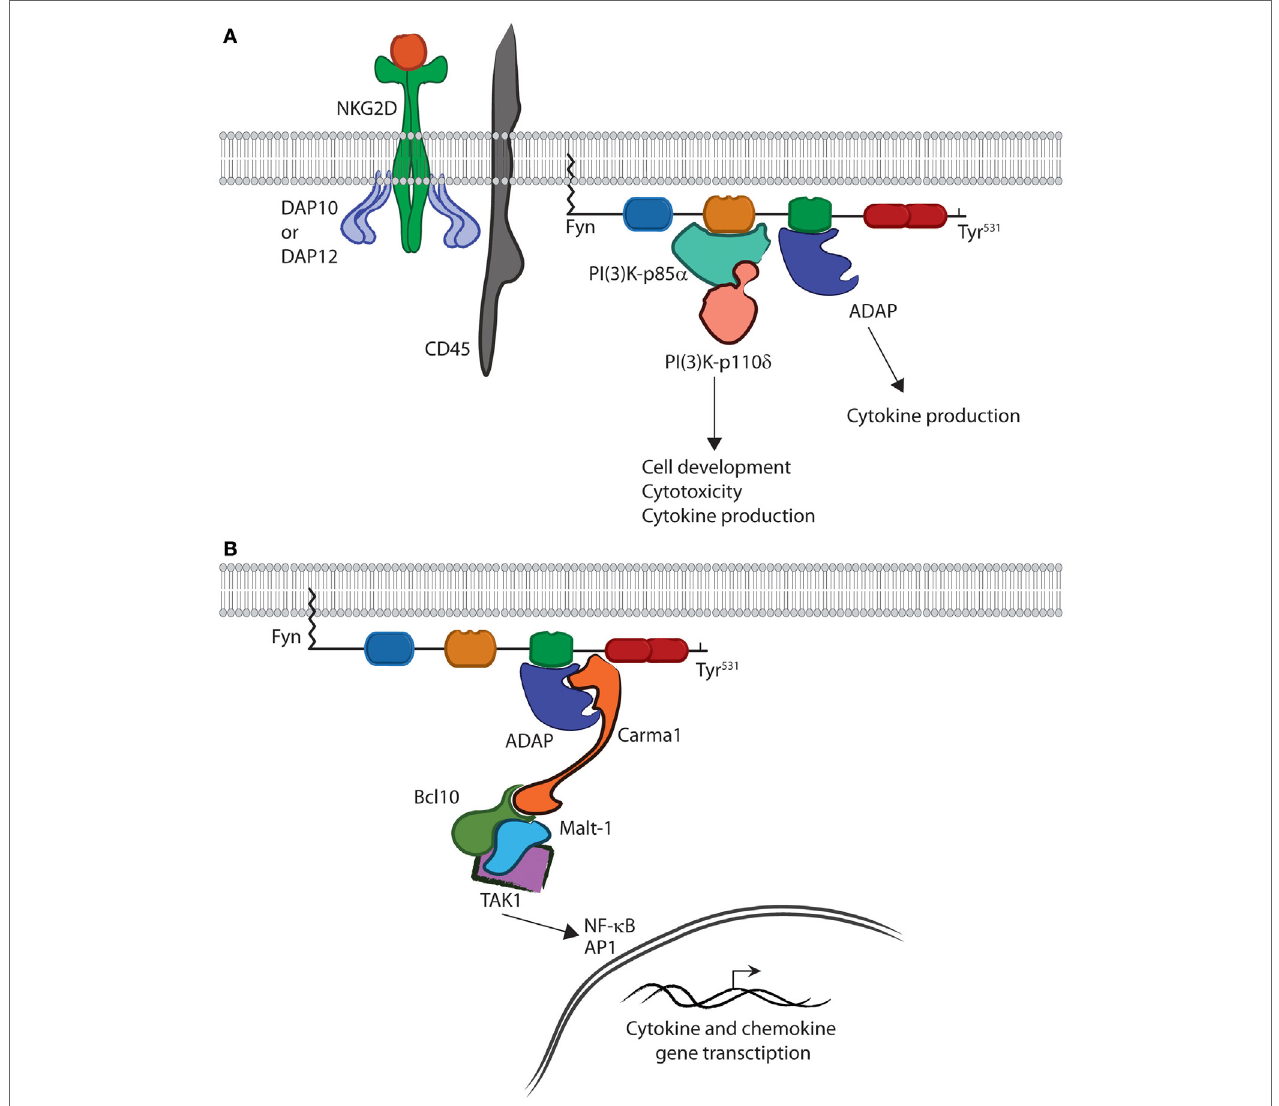
FiGURe 3 | Fyn is capable of activating divergent signaling cascades . (A) In the active conformation, the SH2 and SH3 domains bind downstream effectors and activate divergent signaling cascades in lymphocytes. The interaction between PI(3)K-p85 α and the SH3 domain of Fyn controls multiple aspects of lymphocyte effector functions. The SH2 domain of Fyn binds ADAP via the YDGI motif following tyrosine phosphorylation by Fyn. This stabilizes ADAP and initiates a unique set of lymphocyte functions, such as cytokine production. (B) ADAP translocation and stabilization leads to CBM complex formation. Carma1 binds to ADAP and initiates the recruitment of Bcl10 and Malt1. This leads to TAK1 binding and activation of its kinase activity. TAK1 then activates NF- κ B or AP-1. Once activated, NF- κ B and AP1 translocate to the nucleus where they induce transcription of cytokine and chemokine